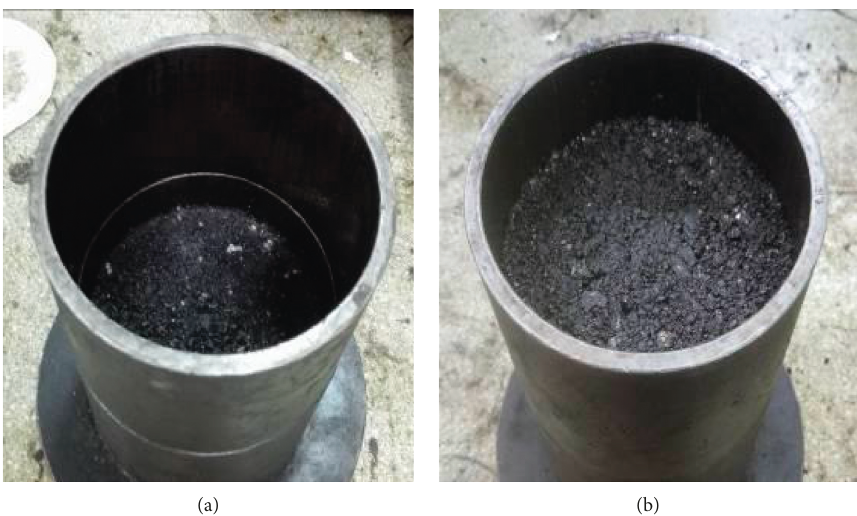
Figure 2: Mixture of single layer and double layer. (a) Single layer. (b) Double layer.